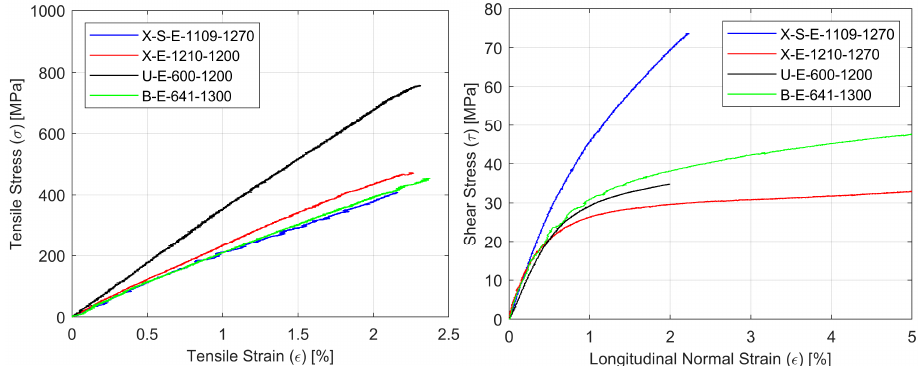
Figure 5. Representative curves for composite specimens with different glass fiber composites for tensile tests σ - ε ( left ) and shear by tensile test τ - ε ( right ). Table 4. Test results in the second stage of the research.